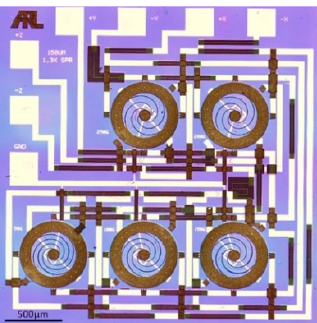
Figure 4. Full chip with five triaxial switches and a resistor ladder [3].